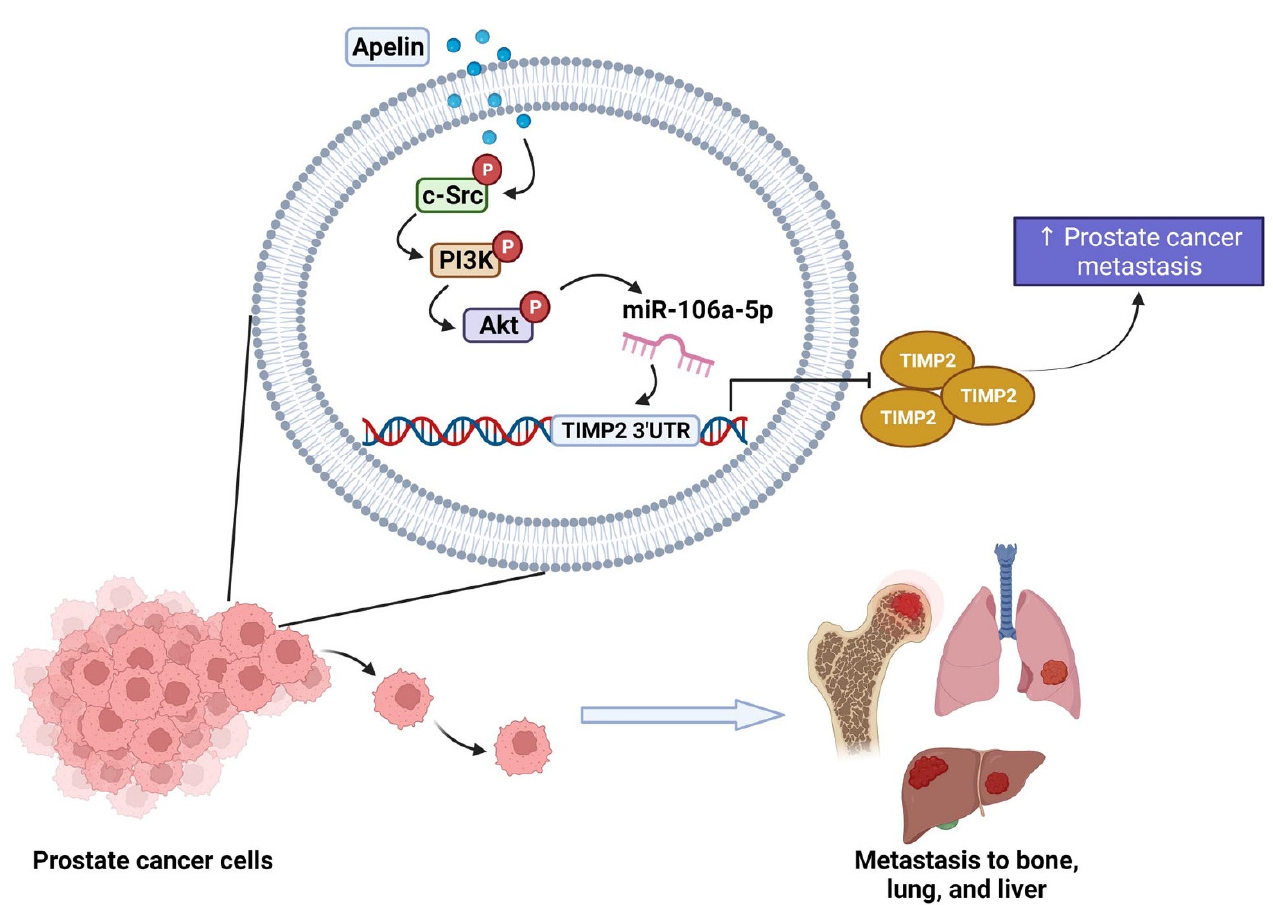
Figure 8. Schematic diagram summarizes the mechanisms by which apelin facilitates metastasis in human prostate cancer cells. Apelin suppresses TIMP2 production and subsequently facilitates the metastatic potential of human prostate cancer cells by increasing miR-106a-5p production via the c-Src, PI3K and Akt signaling pathways.